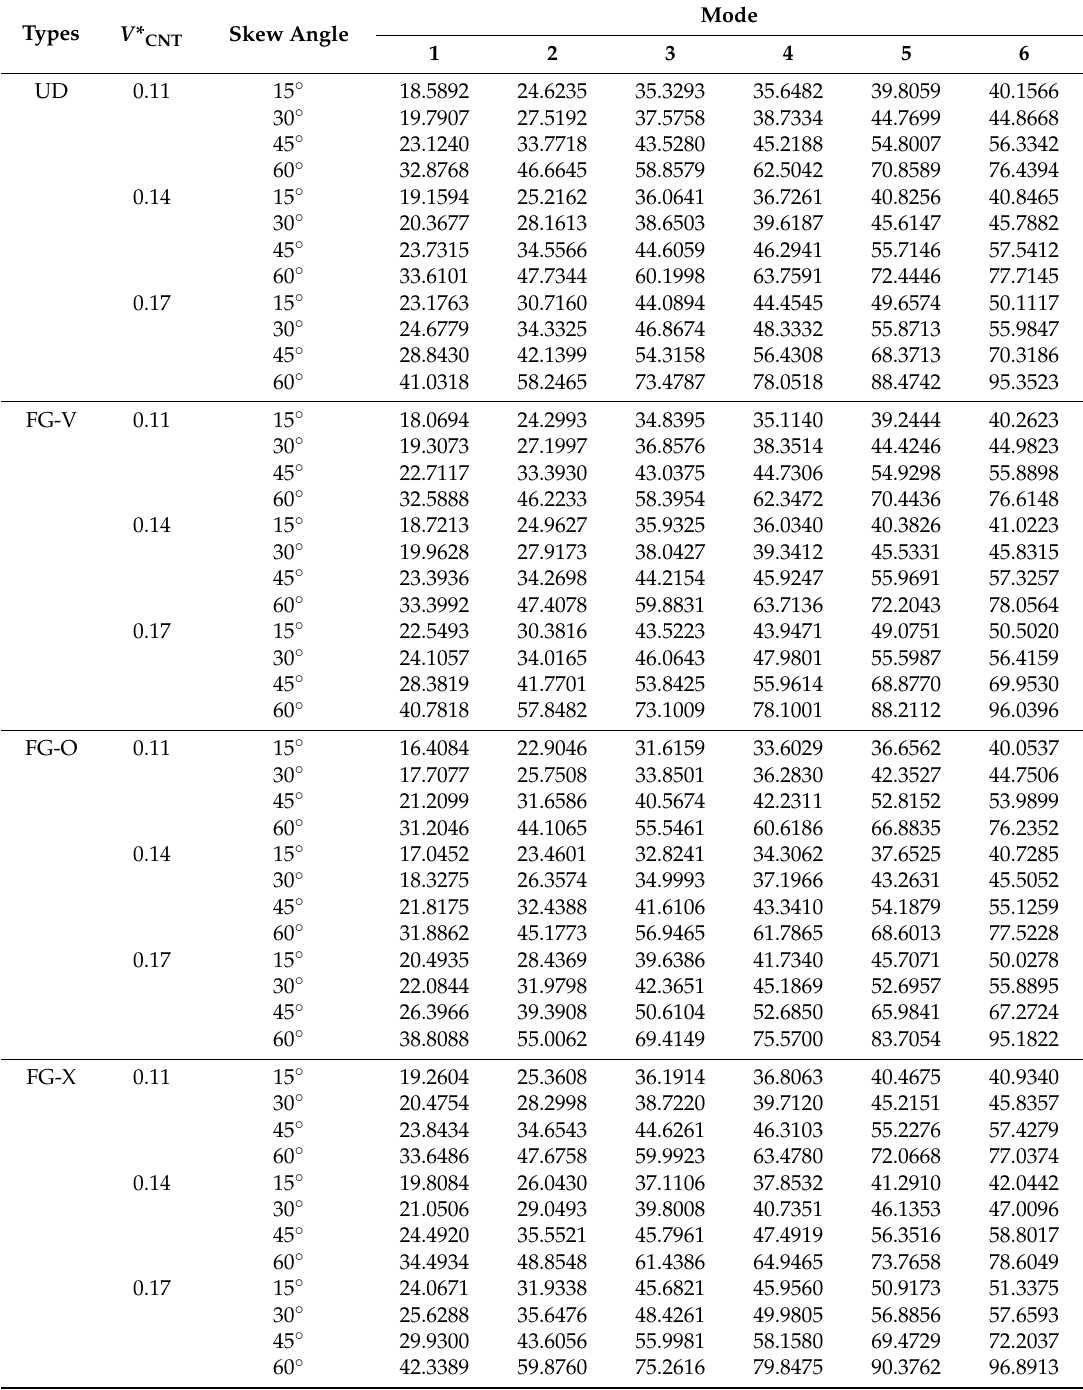
Variation of first six natural non-dimensional frequency parameters of clamped FG-CNT-reinforced rhombic